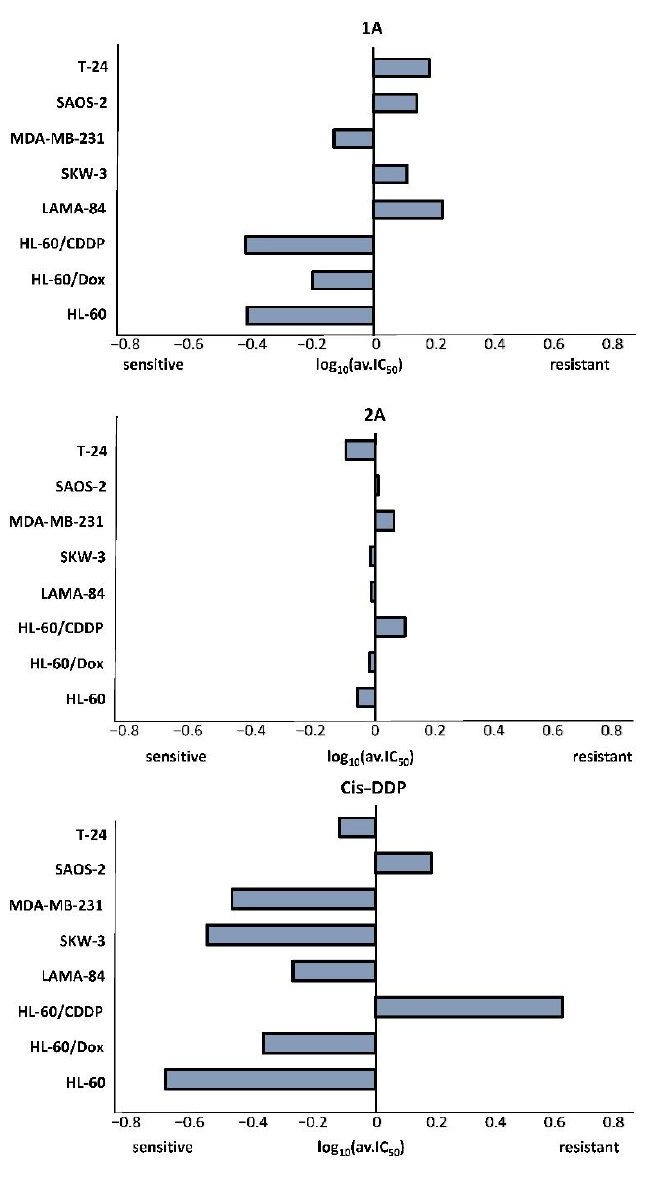
Figure 8. Comparative representation of “mean graph” diagrams generated for the novel compounds and Cis-DDP. Each “mean graph” represents a pattern created by plotting positive and negative values ( deltas ) generated from the set of IC 50 values. The positive and negative values are plotted along a vertical line representing the mean response of all the cell lines in the panel to the tested compound. The negative values project to the left of the neutral vertical line and denote cellular sensitivities to the tested agent that exceed its mean activity. The positive deltas project to the right and represent cell line sensitivities to the test agent that are less than the average inhibitory activity value.